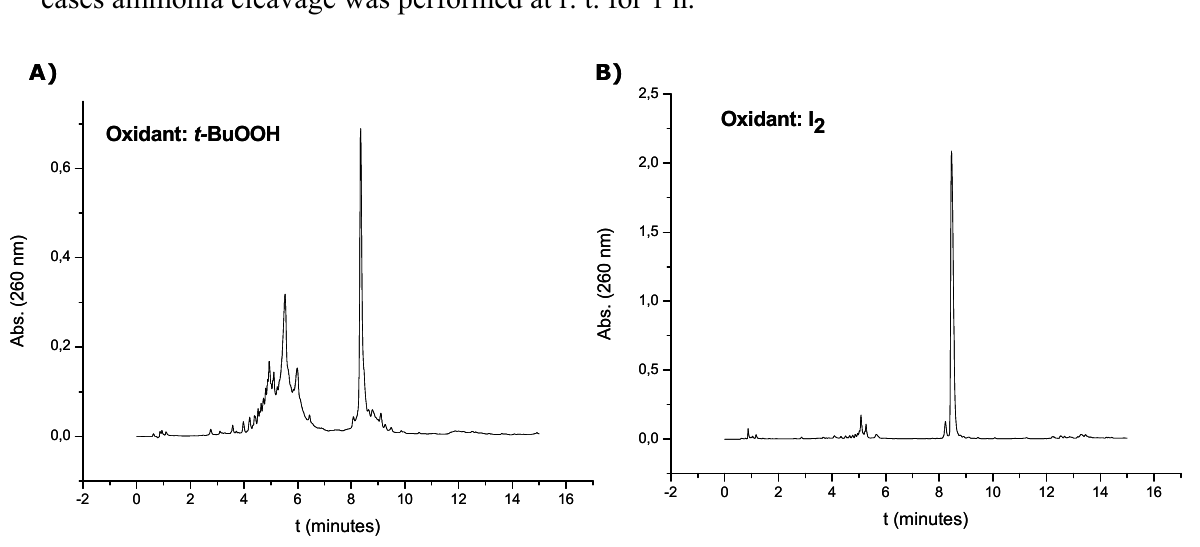
Figure 1. HPLC profiles of crude oligonucleotide 7 using different oxidants: ( A ) 10% tert -butyl hydroperoxide solution in ACN and ( B ) standard 0.02 M iodine solution. In both cases ammonia cleavage was performed at r. t. for 1